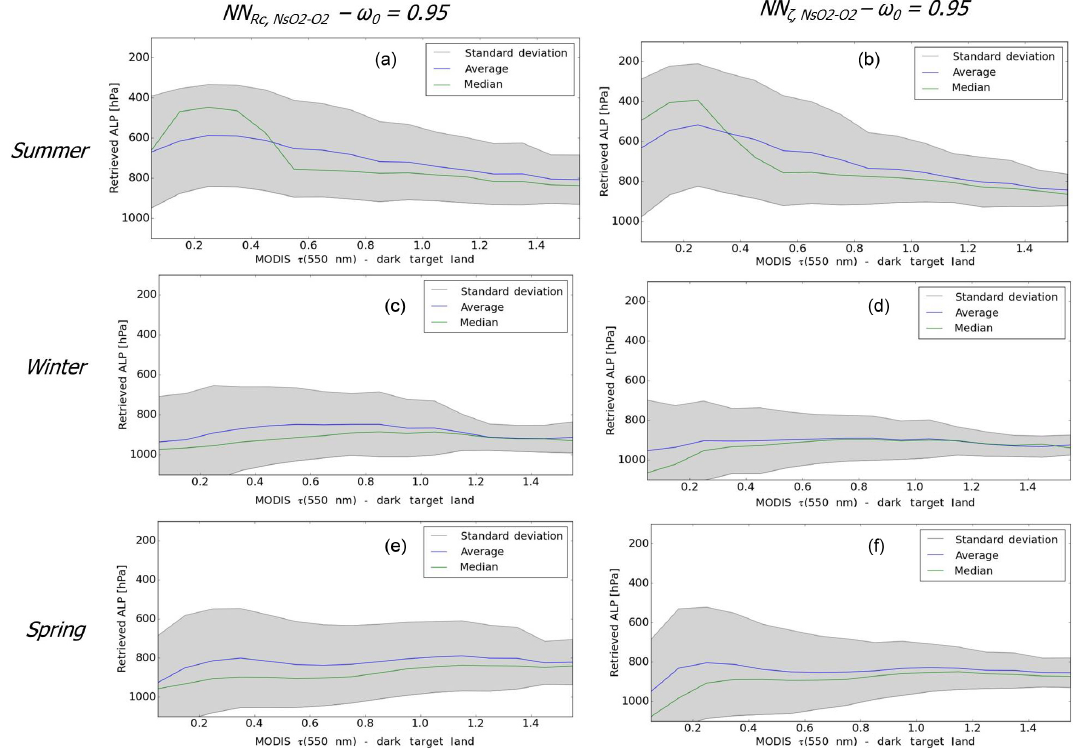
Figure 15. Collocated retrieved OMI ALP (assumed aerosol model with ω 0 = 0.95 and based on the OMLER surface albedo) and MODIS Aqua τ (550nm) over north-east Asia for cloud-free scenes and summer, winter and spring seasons. Statistics are computed over 3 years, 2005–2007: (a, c, e) OMI retrievals are from the NN R configuration; (b, d, f) OMI retrievals are from the NN τ,N s configuration c ,N s O2 − O2 O2 − O2 with MODIS Aqua τ (550nm), from Dark Target land algorithm, as input (see Sect.